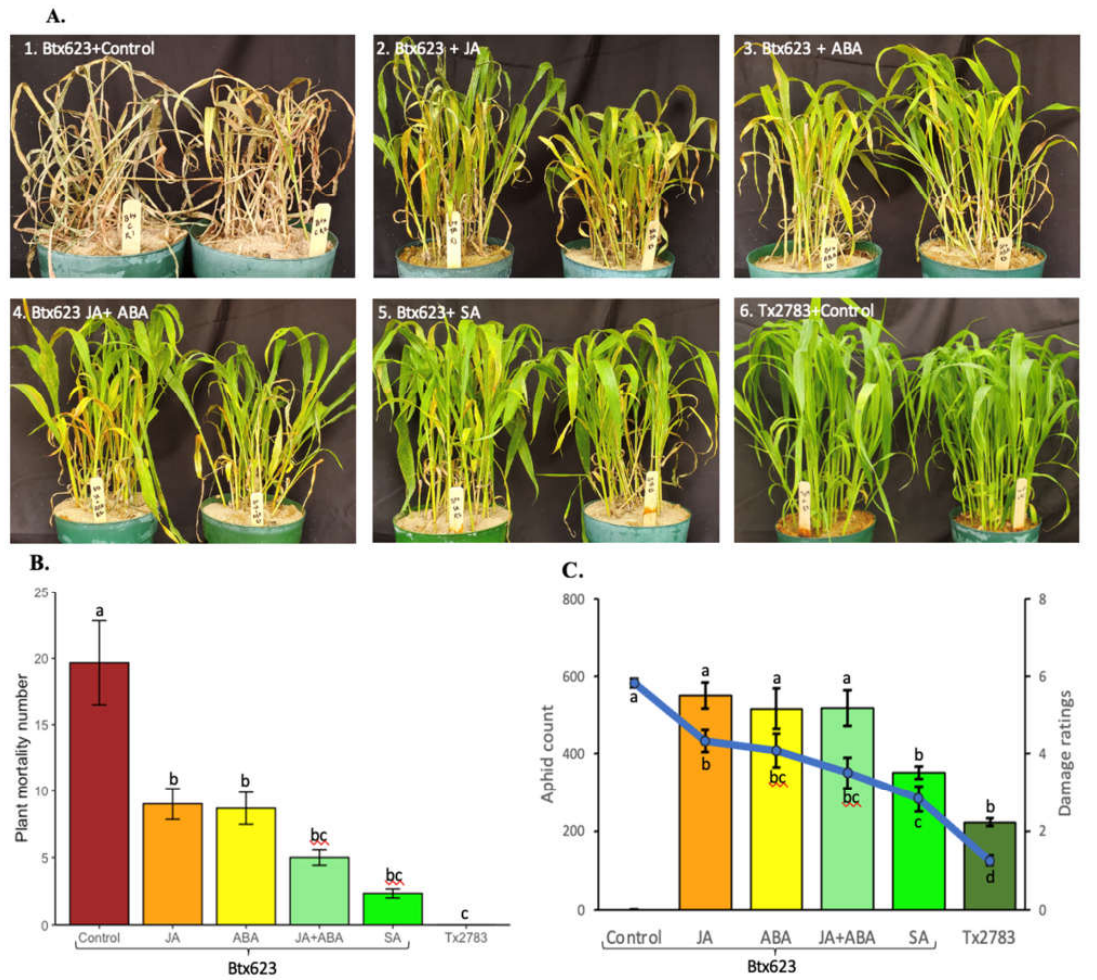
Figure 6. Phytohormone treatment results on BTx623 and Tx2783 after 14 days of SCA infestation. The BTx623 samples were treated with different concentrations of phytohormones and the control samples of BTx623 and Tx2783 were sprayed with distilled water. All treatments were infested with 400 SCA. After 14 days, a status of plant ( A ), plant mortality ( B ) and aphid counts and damage ratings were recorded ( C ) for each treatment. Statistical analysis for plant mortality, aphid counts, and damage ratings was performed through one-way ANOVA and Tukey test. Error bars in plant mortality represent ± standard error ( n = 3) and in aphid counts and damage ratings represent ± standard error ( n = 12).